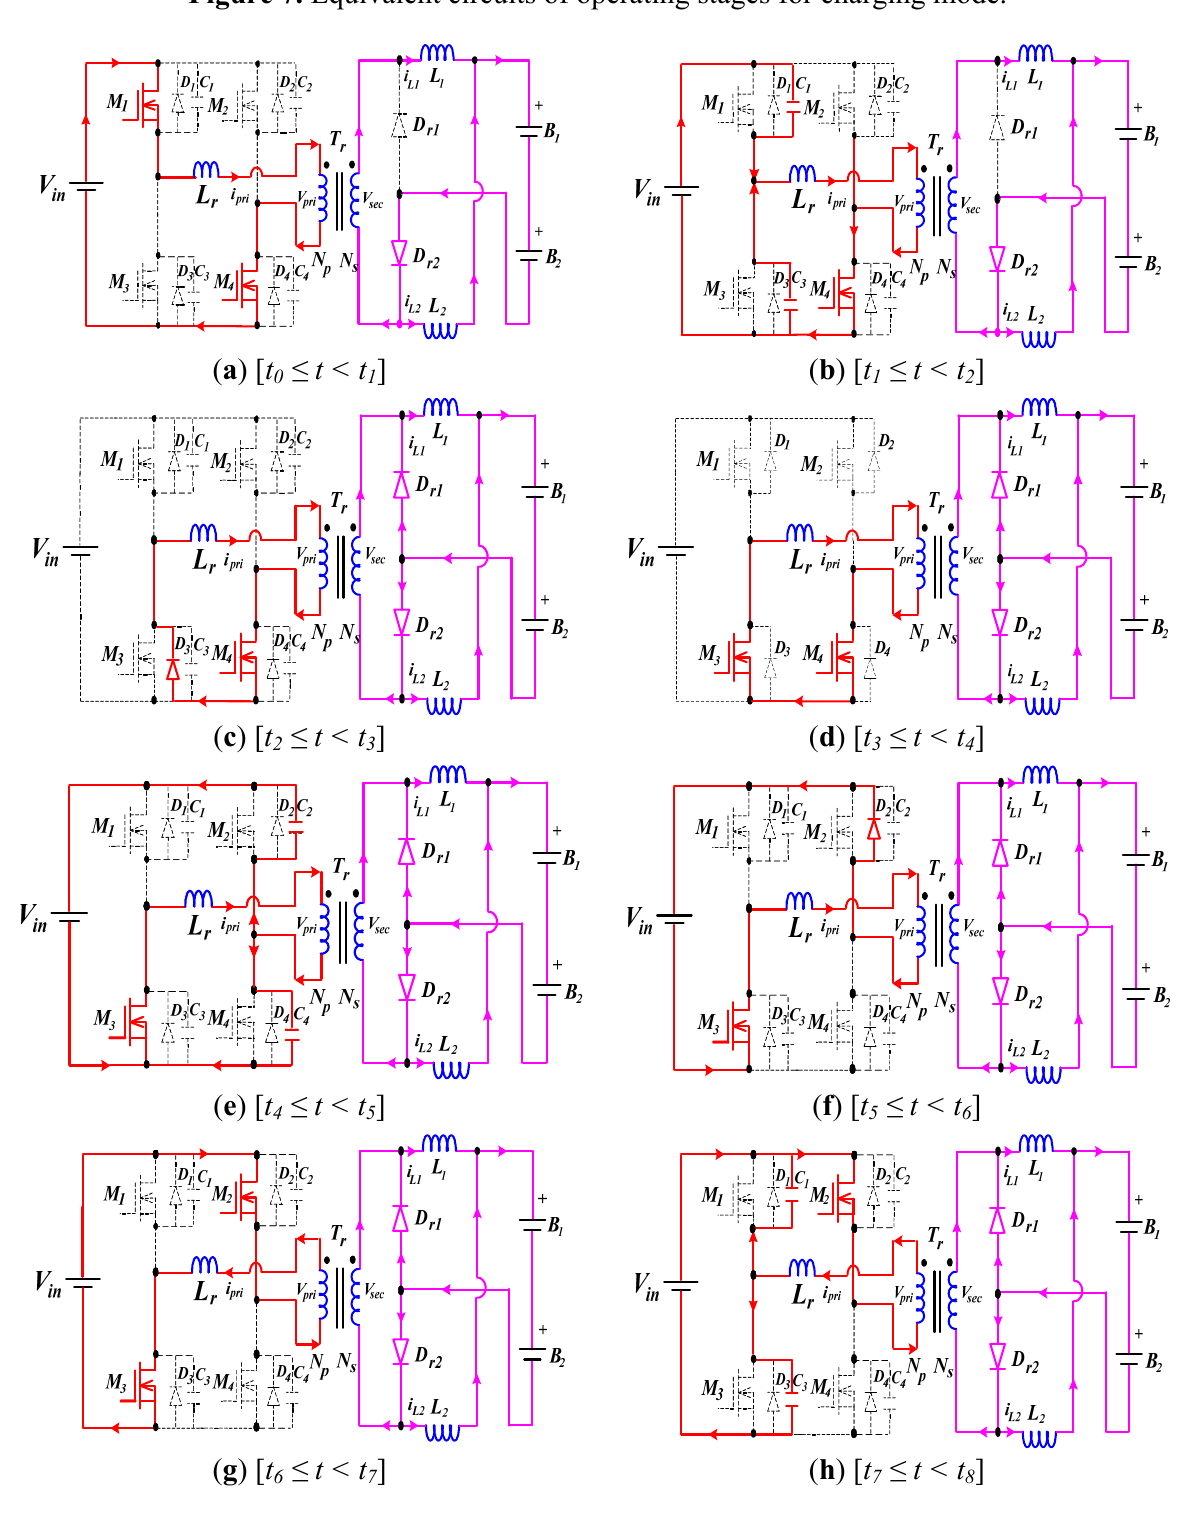
Figure 7. Equivalent circuits of operating stages for charging